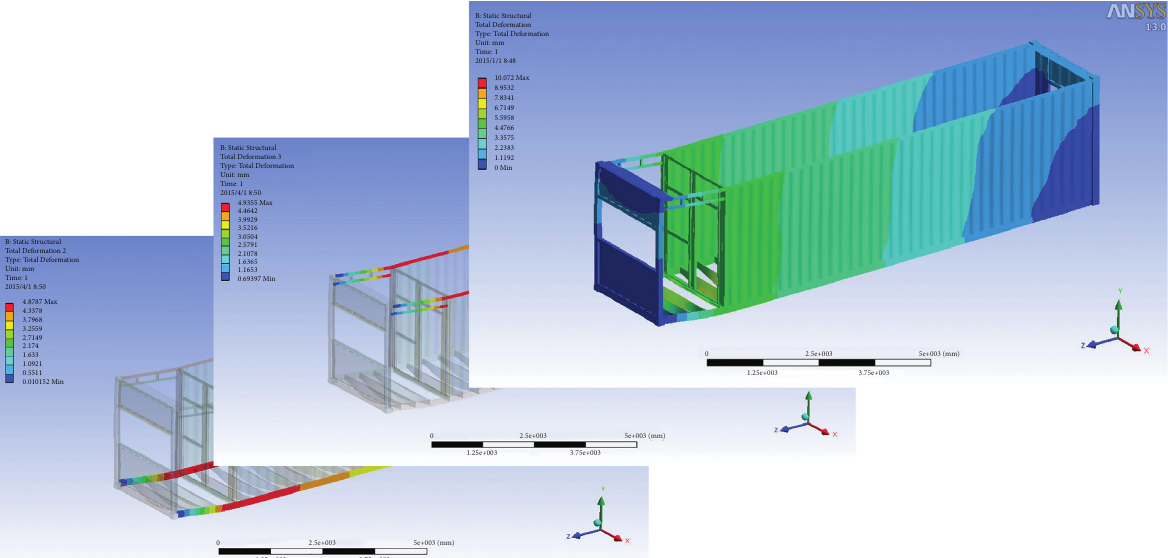
Figure 10: Integrated design information and software relationship based on BIM and PDM.